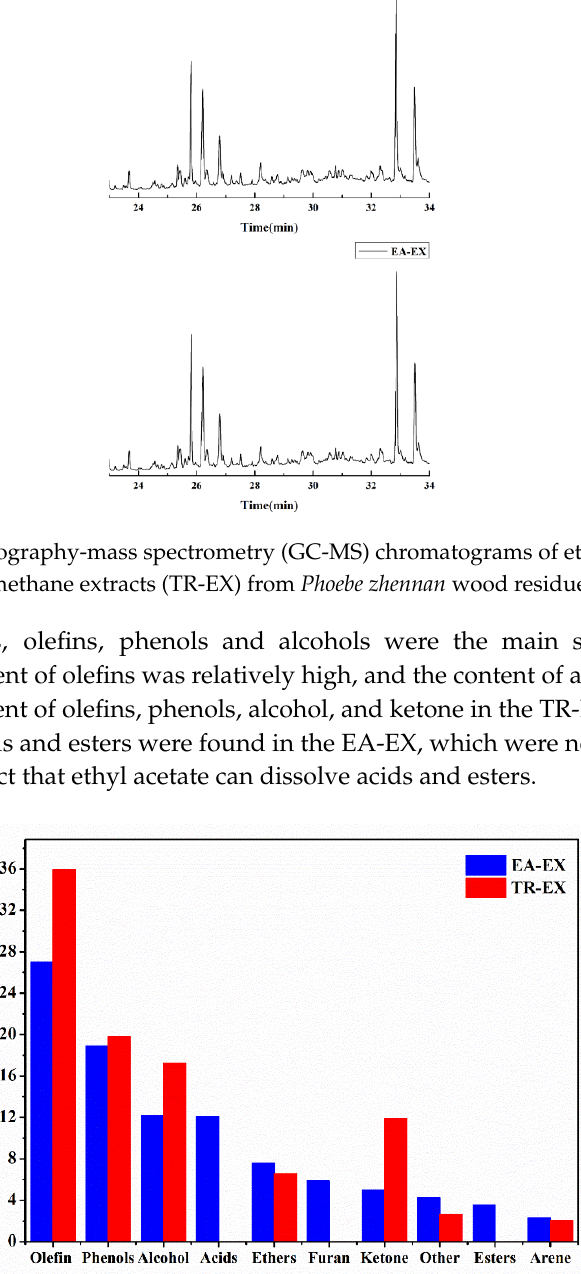
Figure 2. The relative content of compound species in ethyl acetate extracts (EA-EX) and trichloromethane extracts (TR-EX) from Phoebe zhennan wood.